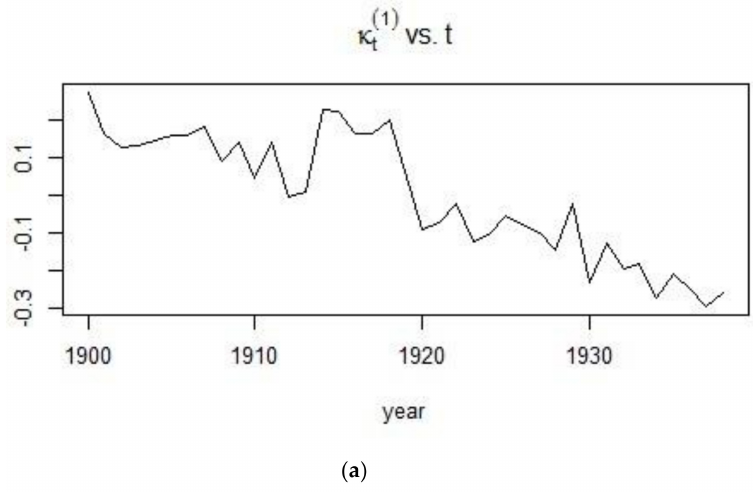
Figure 4. The evolution of the first age-dependent parameter of the APC model during the ( a ) 1900–1938 period and ( b ) 1961–1990